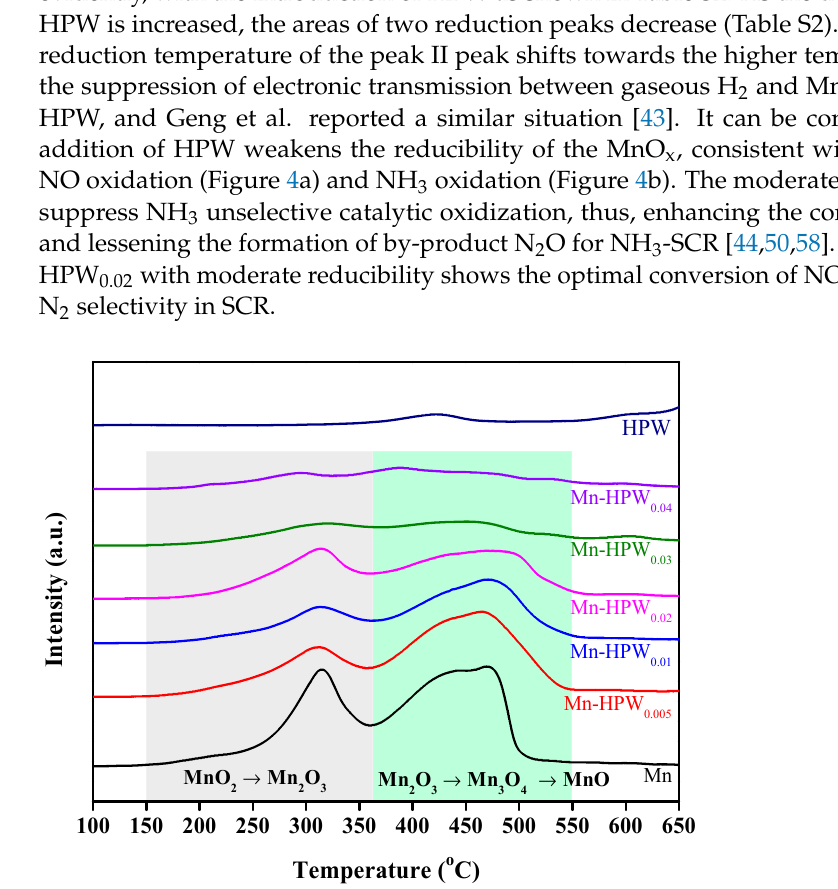
Figure 8. In Figure 8a, the peaks of Mn 2p 3/2 and Mn 2p 1/2 are inspected at ~642.0 eV and ~654.0 eV, respectively, and the Mn 2p 3/2 spectra are deconvoluted and fitted by Gaussian- Lorentz into three subpeaks, including Mn 2+ (640.8 ± 0.1 eV), Mn 3+ (642.0 ± 0.2